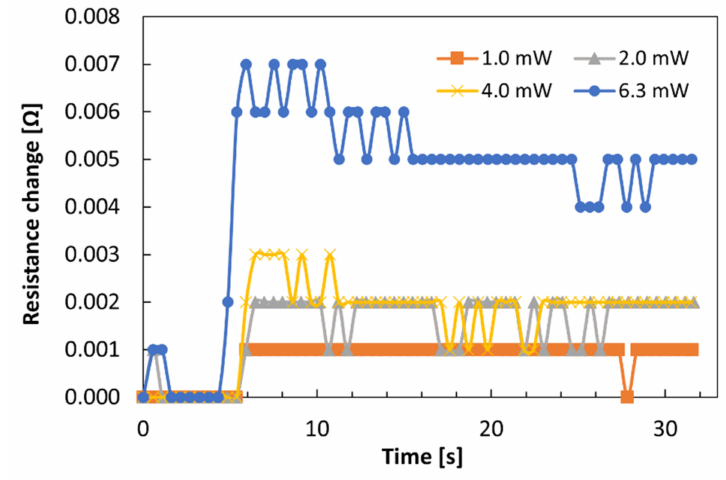
Figure 7. Transition of the measured resistance change after light injection of 1.0, 2.0, 4.0, and 6.3 mW for TM mode light with the Si waveguides with 200 nm-thick SiO 2 buffer layer. Input light was injected at t = 4~5.5